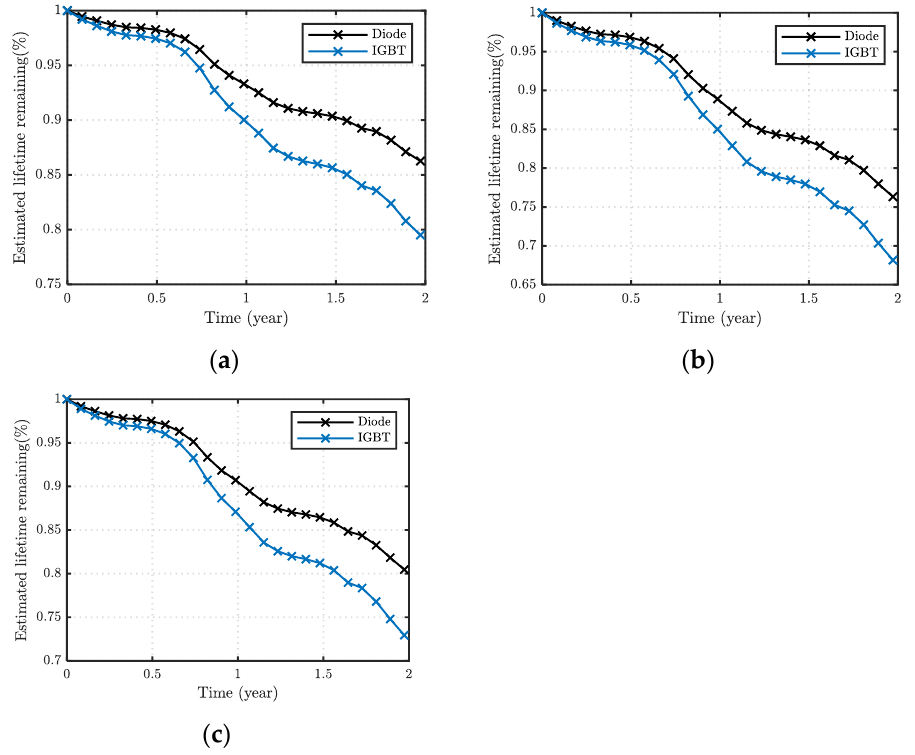
Figure 14. Monthly remaining-lifetime remaining from the fatigue simulation. ( a ) MPPT; ( b ) TES with USD 0.101/kWh rate; and ( c ) TES with USD 0.201/kWh rate.